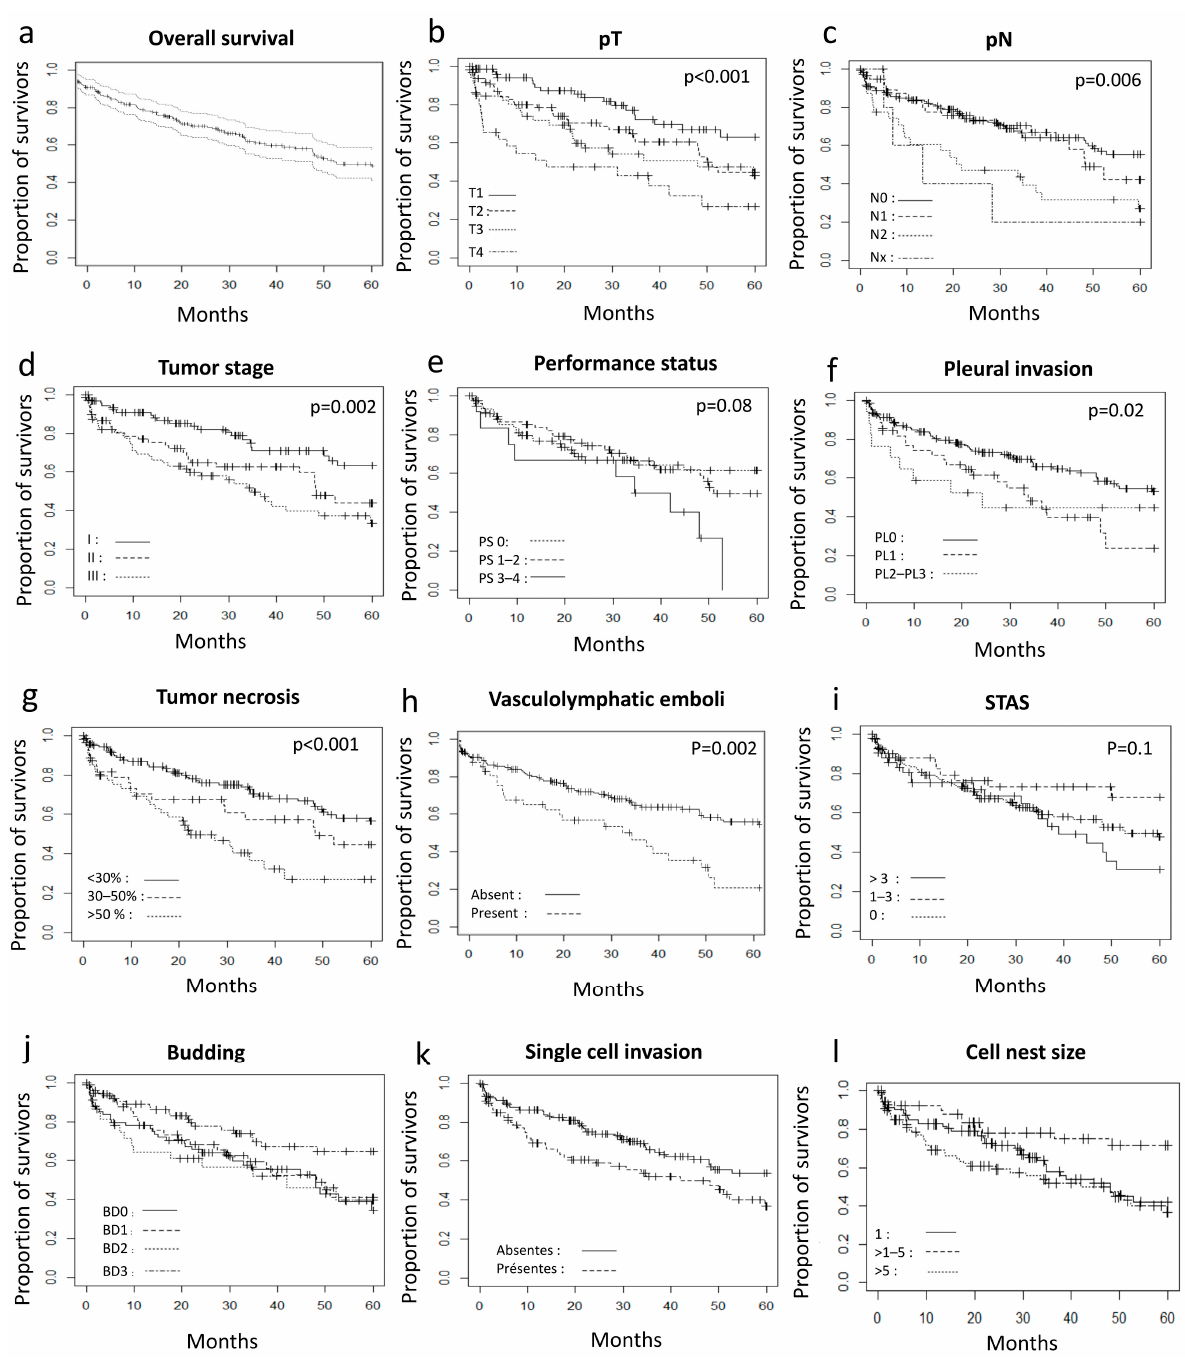
Figure 2. Kaplan–Meier curves for 5-year overall survival according to clinical and pathologi- cal parameters. ( a )—Overall Survival with 95% confidence intervals. ( b )—pT stages. ( c )—pN stages. ( d )—Tumor stage. ( e )—Performance status. ( f )—Pleural invasion. ( g )—Tumor necrosis. ( h )—Vasculolymphatic emboli. ( i )—STAS. ( j )—Tumor budding. ( k )—Single cell invasion. ( l )—Cell nest